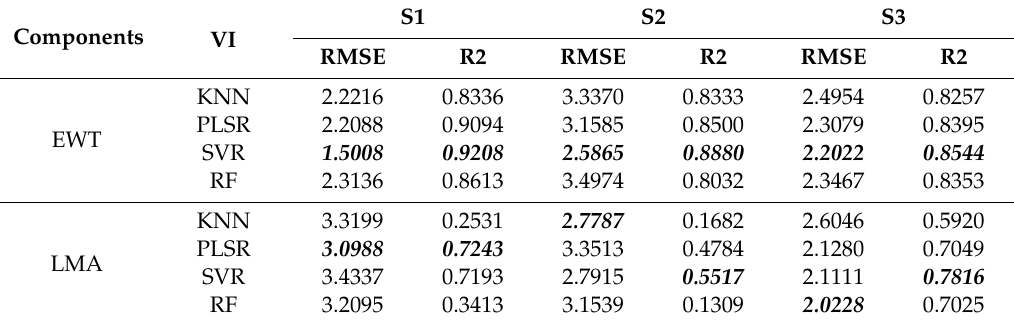
Table 5. Performance of the ML-reflectance-based models for the estimation of EWT and LMA. The italic bold number gives the best performances under a given sampling strategy.